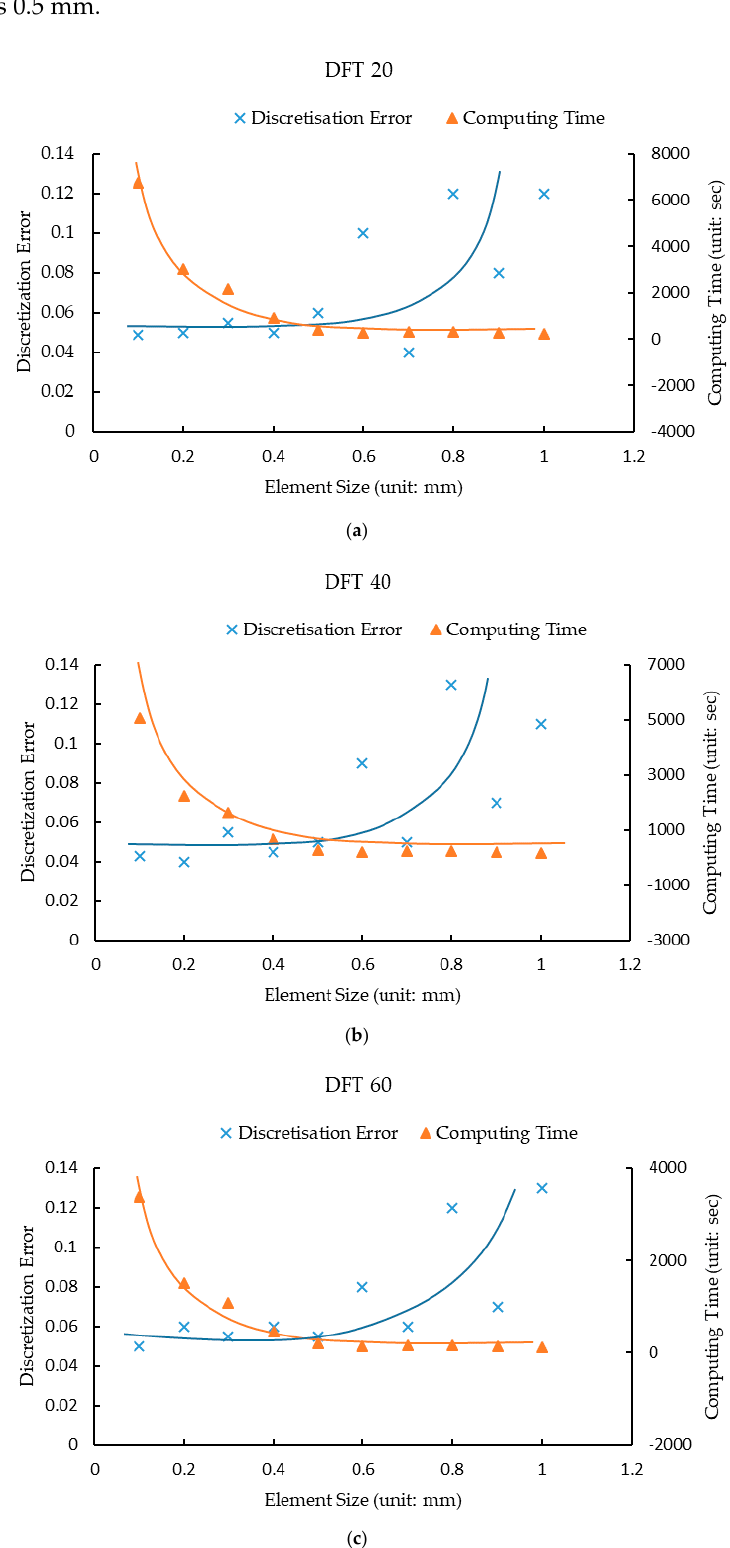
Figure 9. Mesh study results: ( a ) Discretization error vs. computing time at the speed of 20 km / h; ( b ) Discretization error vs. computing time at the speed of 40 km / h; ( c ) Discretization error vs. computing time at the speed of 60 km /